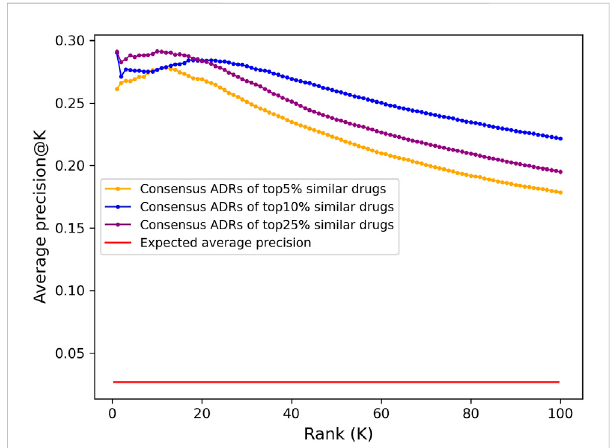
FIGURE 4 Benchmarking performance of various CANDO pipelines. The ability of different CANDO pipelines to accurately determine similarity of drugs known to treat the same indications was assessed using a hold-one-out benchmarking scheme on a per indication basis. All indication accuracies were averaged to compute the average indication accuracy (AIA; blue), along with counting the number of indications with a non-zero accuracy, or indication coverage (IC; red). The performance of the pipeline using linear proteomic signatures with a library of 8,385 human proteins and the chemical fi ngerprint pipeline are depicted and compared to the pipeline with human multiscale interactomic networks. The latter was created from continuous-valued low dimensional embeddings based on connectivity of the heterogeneous biological network (see Methods). The multiscale pipeline also comprised a set of the top25 predicted ADR associations for all compounds generated using a consensus voting scheme (see Section 4.6). This multiscale ADR association pipeline achieved an average indication accuracy of 28.1% which exceeded the performance of both the proteomic signature and fi ngerprint pipelines of 20.7% and 23.6%, respectively, and was over fi ve times that of the random control value of 5.3% (dashed blue). This was also true for indication coverage where the ADR-enhanced interactomic signatures achieved 57.2%, amounting to 97 additional indications for which there is a non-zero accuracy (out of 1,588), with an expected random control value of 28.3% (dashed red). This further indicated the multiscale interactomic signatures captured compound behavior more effectively than the less dynamic proteomic and fi ngerprint signature pipelines. Overall, our results demonstrated